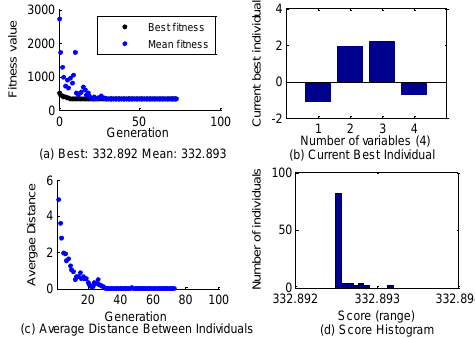
Figure 11. Optimize parameters curves of genetic algorithm. Sensors 2019 , 19 , x FOR PEER REVIEW